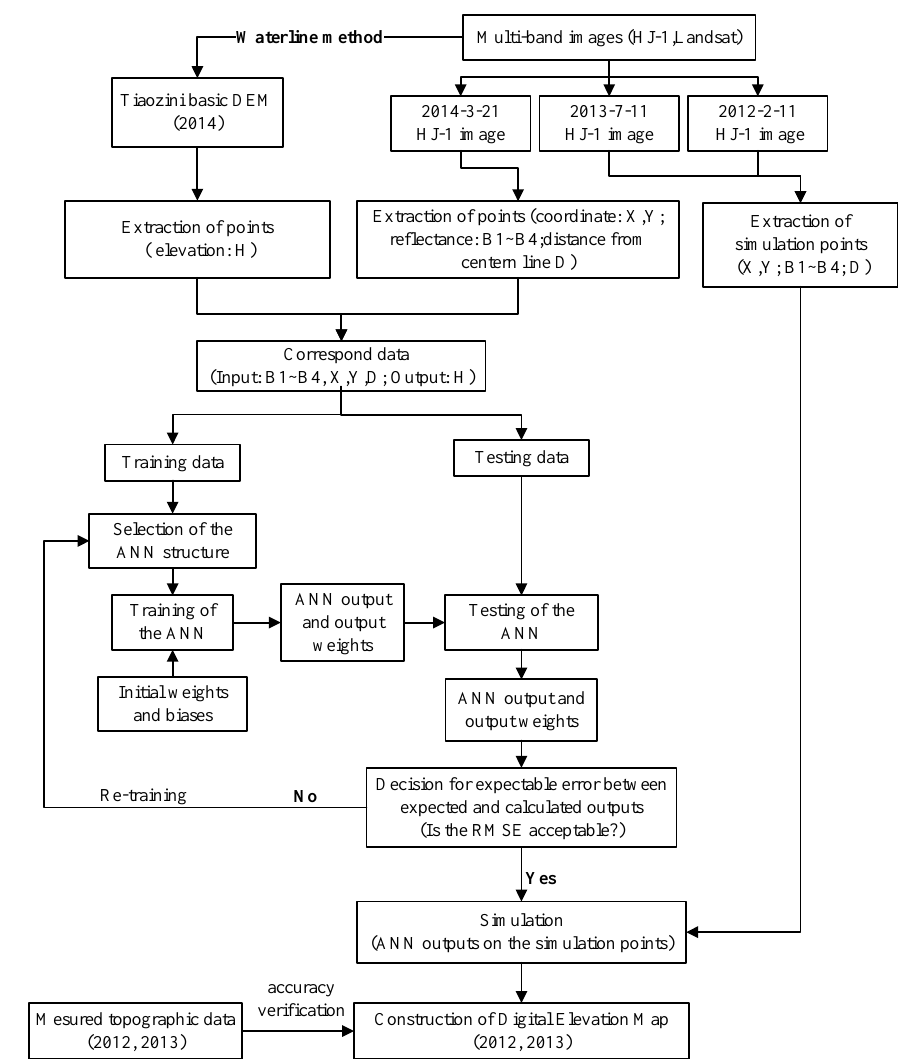
Figure 5. Flowchart illustrating the methodology used in this study.